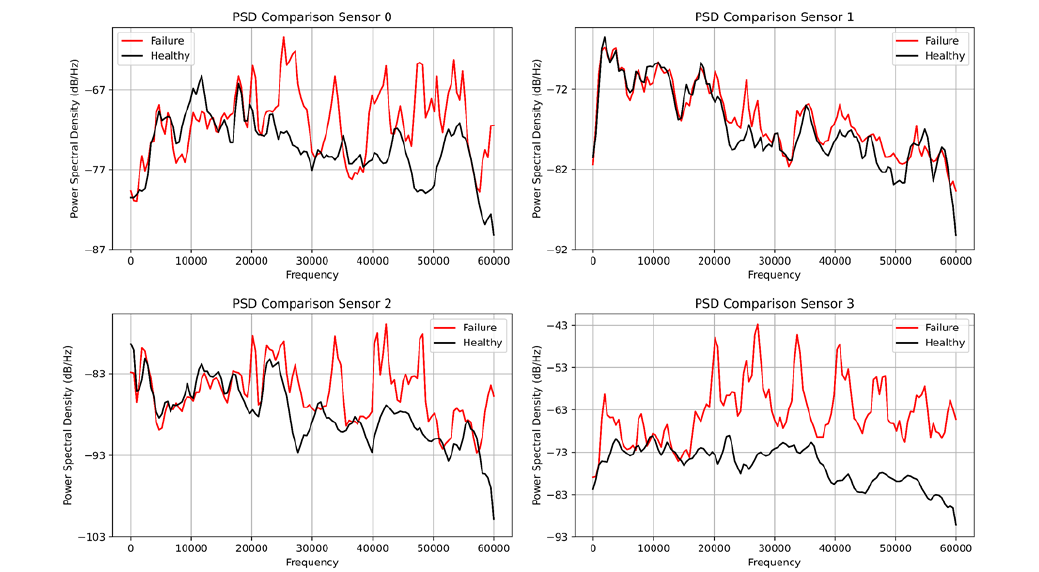
Figure 10. The power spectral density plot from the four sensor vibration